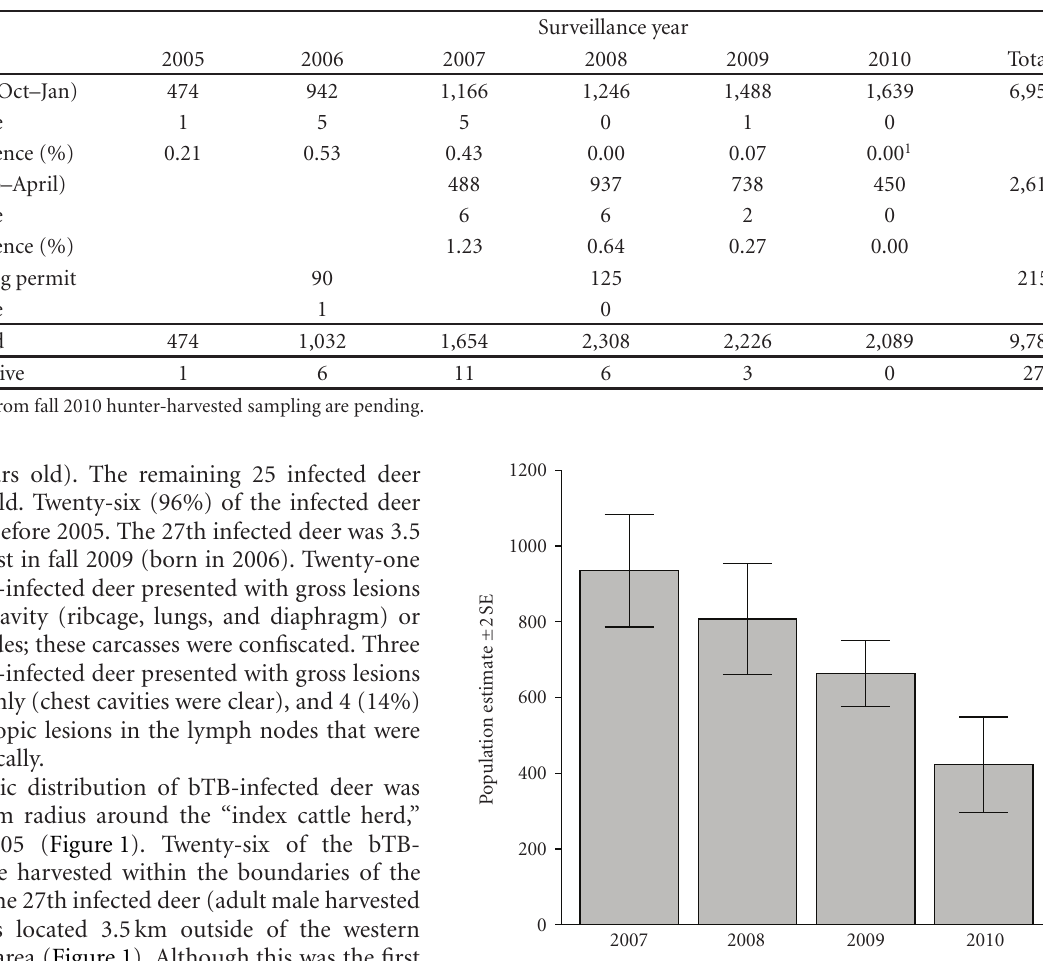
Table 1: Number of deer sampled for bovine tuberculosis (bTB) and testing results listed by sampling strategy, 2005–2010, northwest Minnesota.